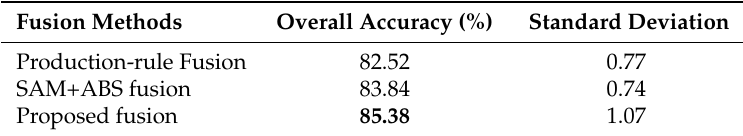
Table 5. Performance comparison of the proposed fusion scheme with other fusion methods, AVIRIS 92AV3C dataset, seven classes, 5% training samples.